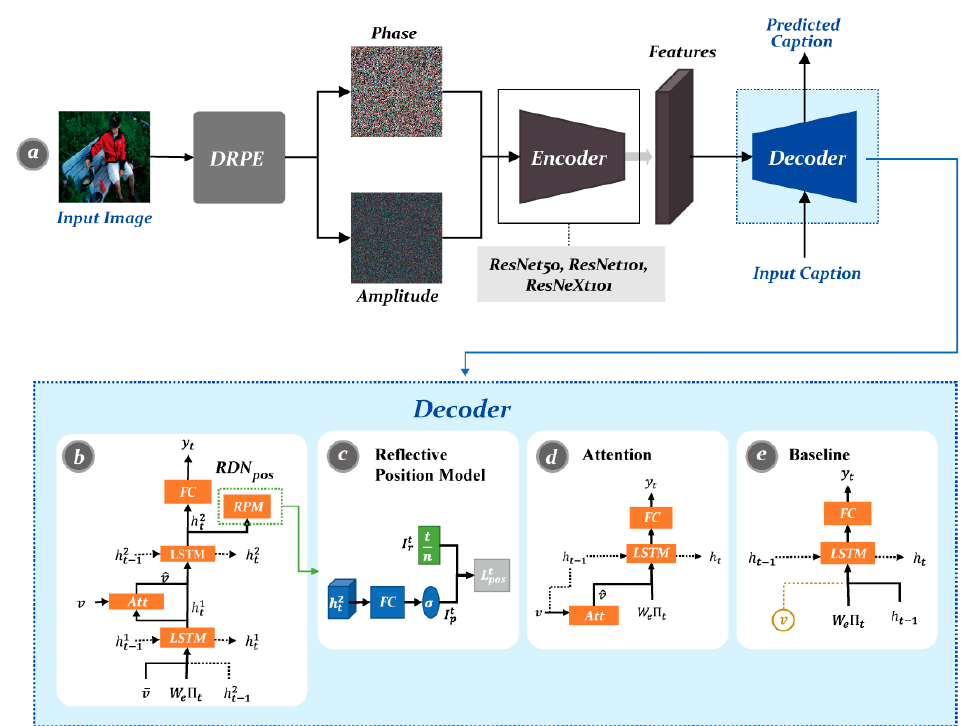
Figure 4. ( a ) Overview of our framework. ( b ) RDNpos decoder. ( c ) Relative position model. ( d ) Attention decoder. Att in ( b , d ) refers to the attention mechanism, which determines the attention distribution over an input image. ( e ) Baseline decoder; without the extracted features, v , as input to LSTM, it is denoted as Baseline-A, otherwise as Baseline-B.